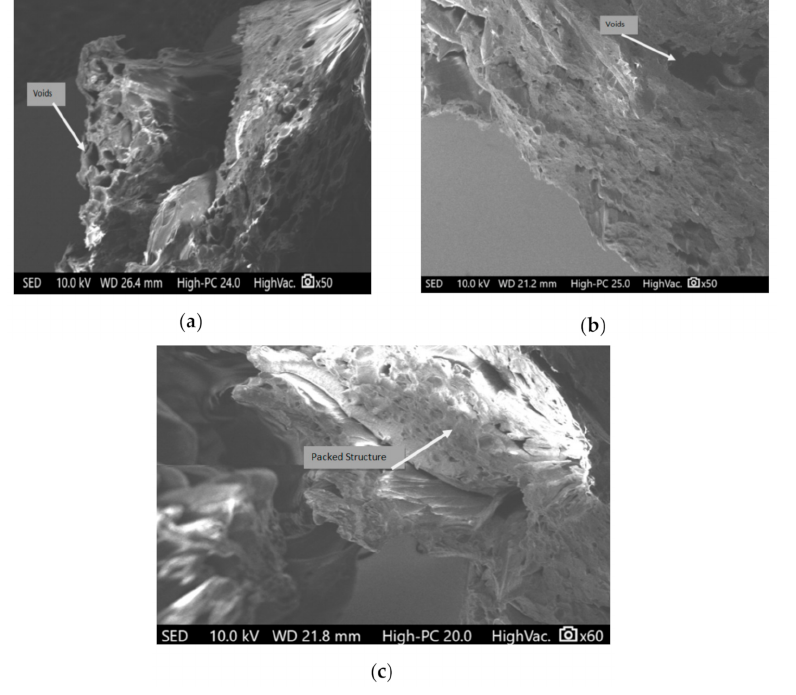
Figure 7. SEM images of ( a ) B5 , ( b ) B6 , and ( c ) B8